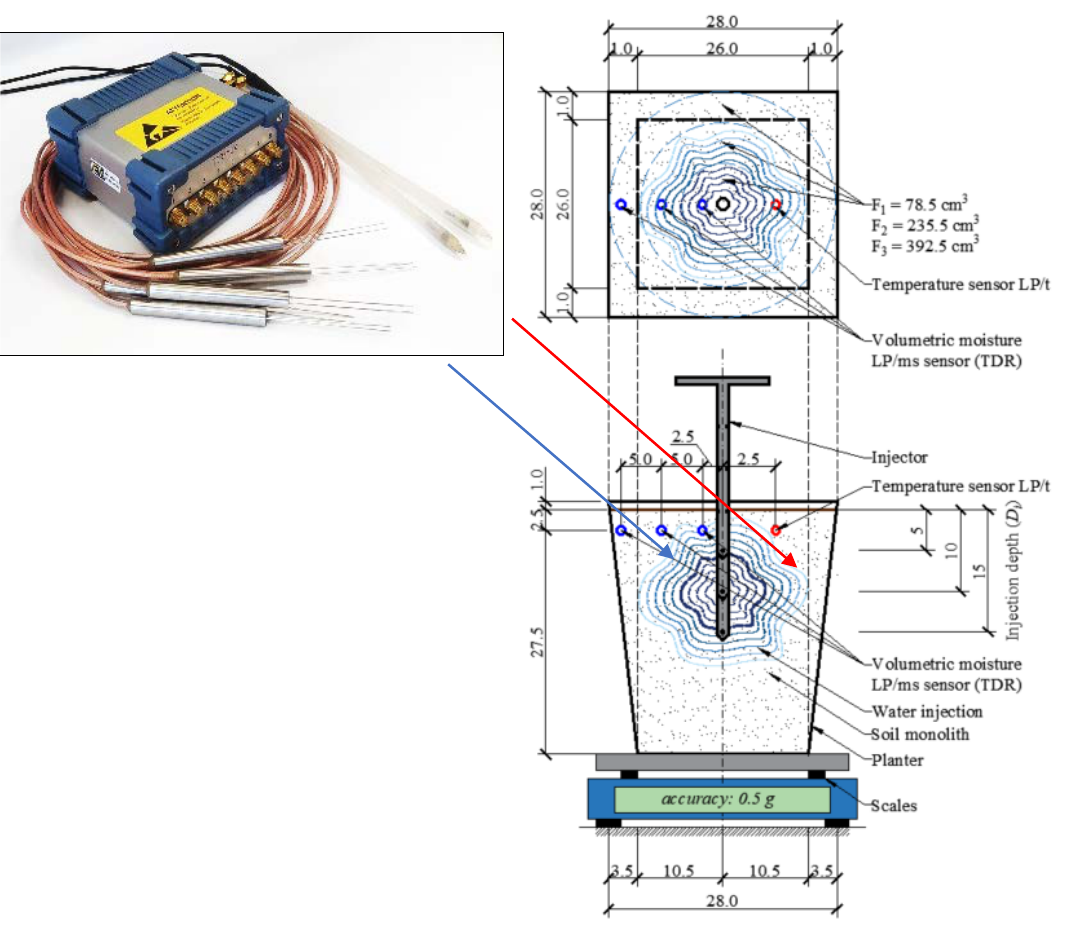
Figure 2. Schematic of a single pot, with the injector, moisture, and temperature sensors, and the balance. F1, F2, and F3 — representative areas for LP/ms (laboratory probe/moisture salinity) probes, dimensions are displayed in centimetres.